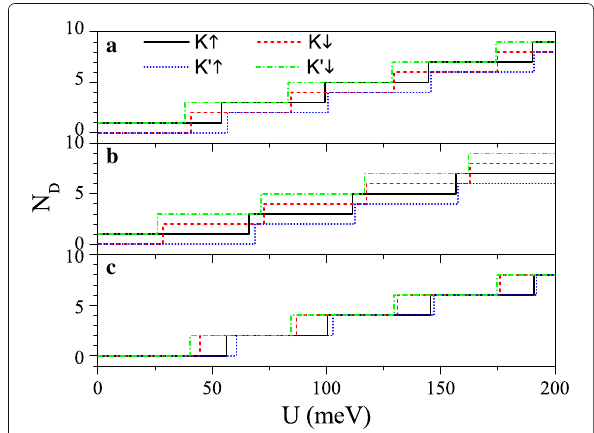
Fig. 3 Number of Dirac points N D versus potential U . ( a ) h = 8.0 meV and (cid:2) z = 7.8 meV; ( b ) h = 20.0 meV and (cid:2) z = 7.8 meV; ( c ) h = 8.0 meV and (cid:2) z = 15.0 meV